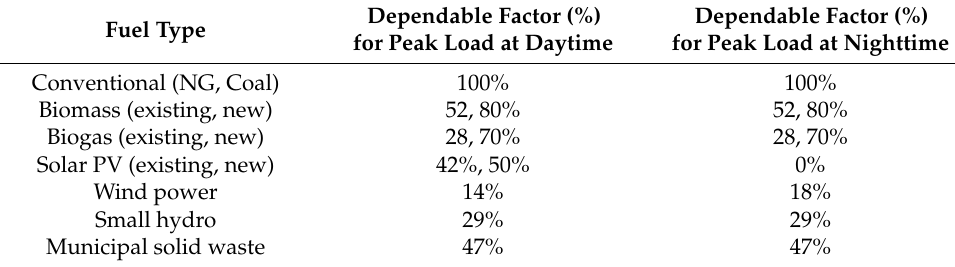
Table 2. Dependable factors or capacity value of renewable energy generation units. Dependable Factor (%) Dependable Factor (%) Fuel Type for Peak Load at Daytime for Peak Load at Nighttime Conventional (NG, Coal) 100% Biomass (existing, new)